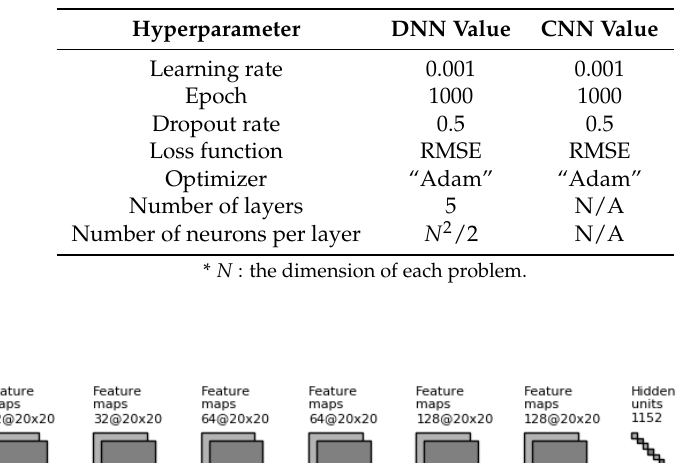
Table 1. The hyperparameter configuration of deep neural network (DNN) and convolutional neural network (CNN).